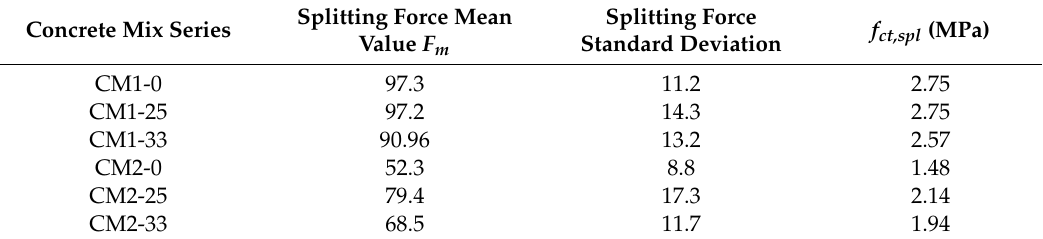
Figure 6. Splitting force of concrete for the tested mix series. Table 8. Tensile strength of concrete at